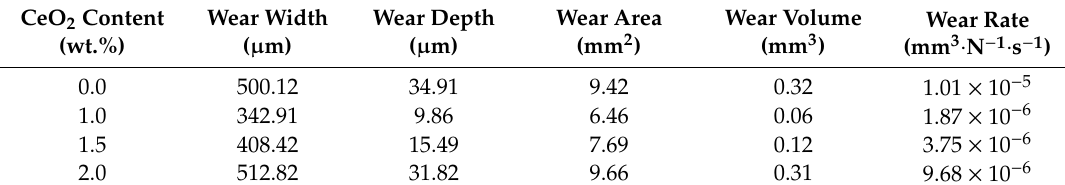
Table 2. Wear test results of coatings.